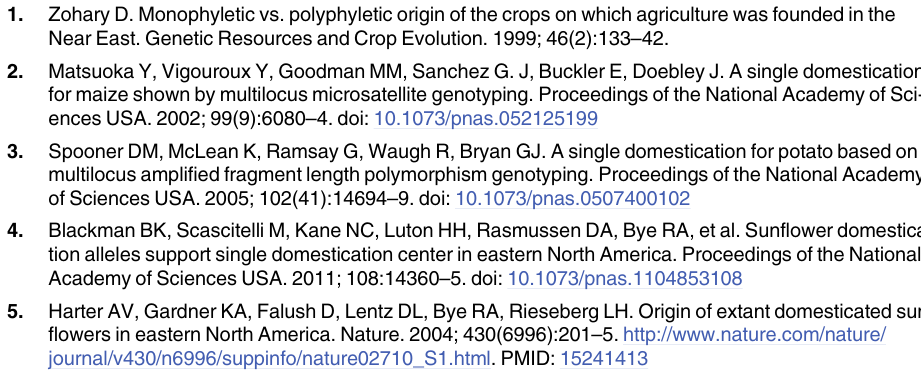
S1 Table. List of genotypes used for the current study and SNPs score.